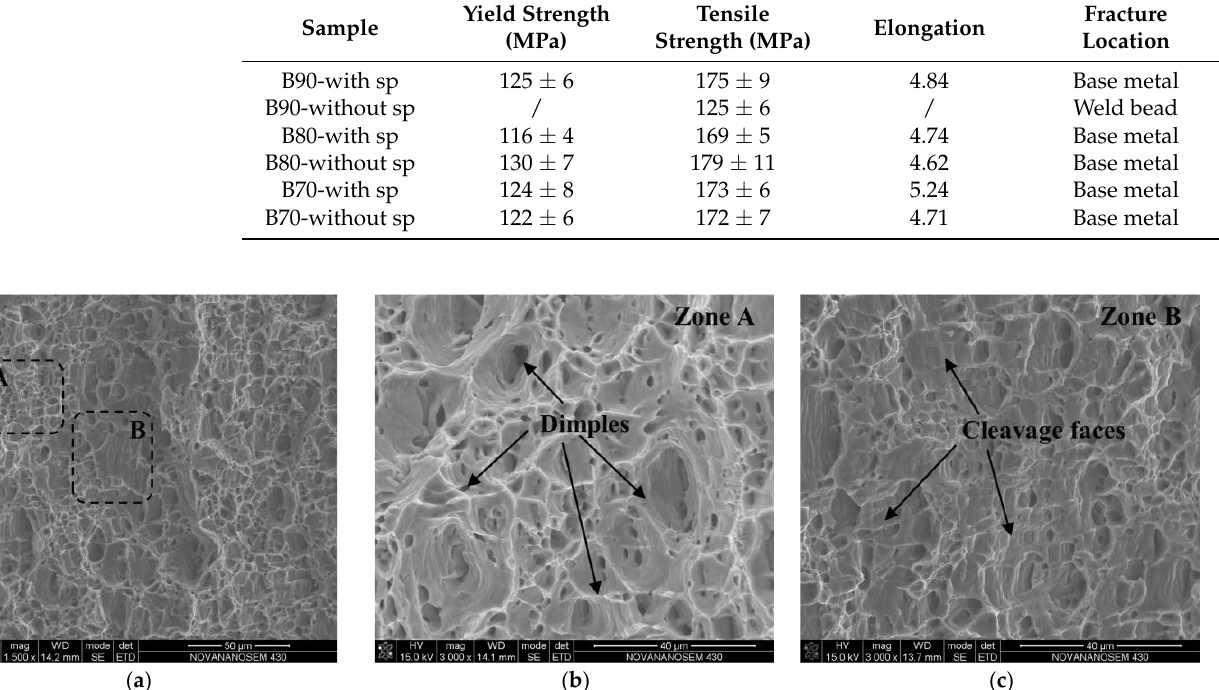
Figure 15. Comparison of tensile results with and without supporting plate. ( a ) Without SP for 177 J/mm; ( b ) With SP for 177 J/mm; ( c ) Tensile property for 177 J/mm; ( d ) Without SP for 190 J/mm; ( e ) With SP for 190 J/mm; ( f ) Tensile property for 190 J/mm; ( g ) Without SP for 204 J/mm; ( h ) With SP for 204 J/mm; ( i ) Tensile property for 204 J/mm; ( j ) Crack position without SP for 204 J/mm; ( k ) Crack position with SP for 204 J/mm. Table 3. Tensile Test Results.